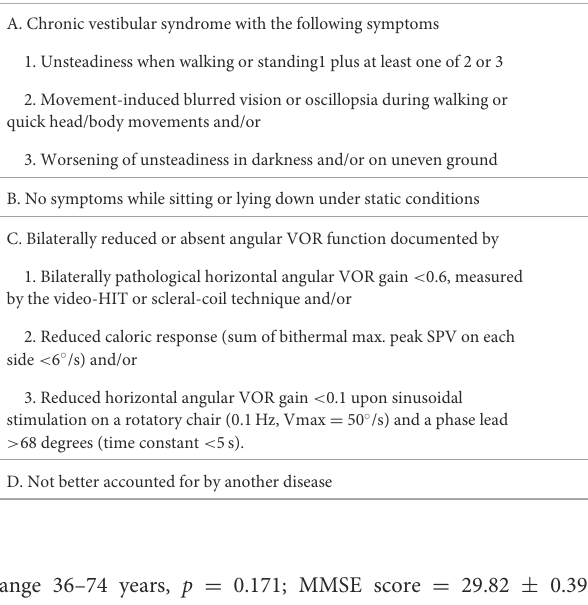
TABLE 1 Diagnostic criteria for bilateral vestibulopathy according to the classification Committee of the Bárány Society